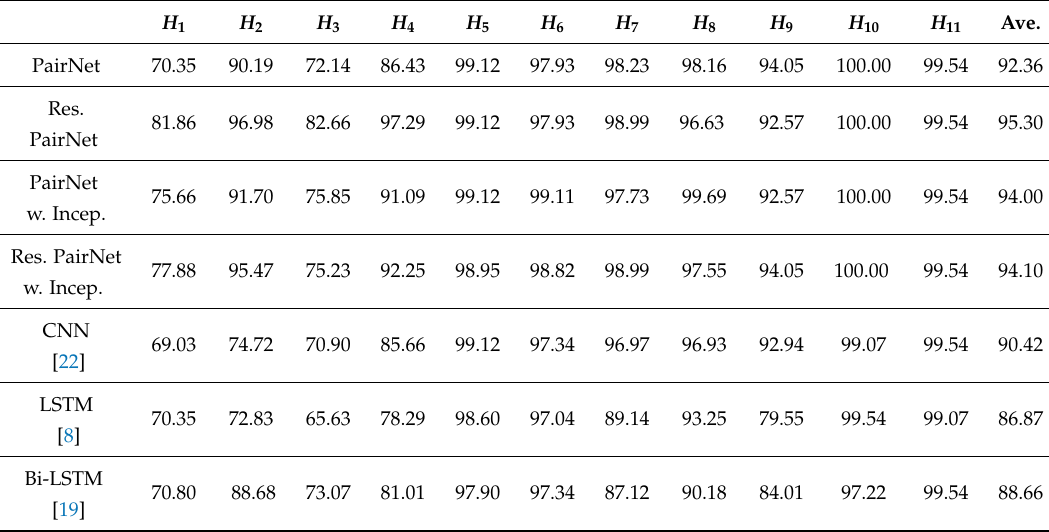
Table 4. The comparisons on hit rates (in percentage) of various algorithms. Both gyroscope and accelerometer are used for the corresponding implementations.